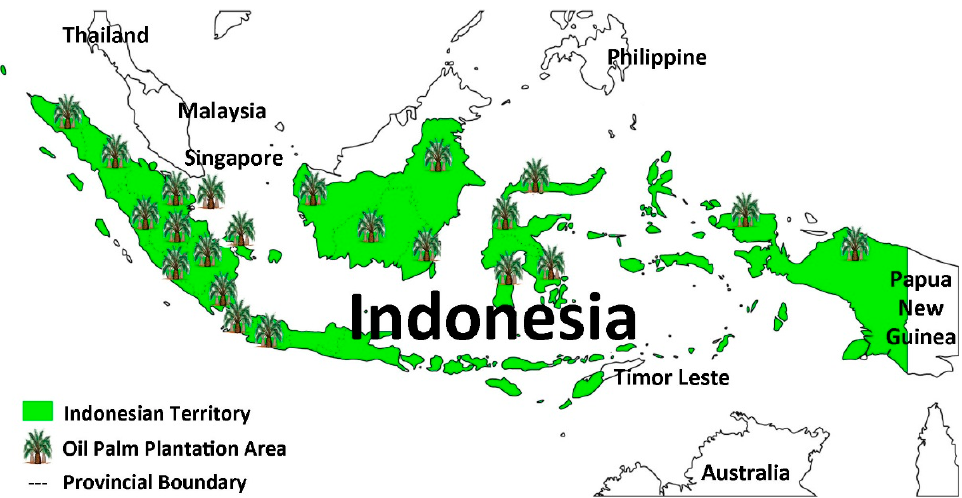
Figure 1. Palm oil plantations in Indonesia.